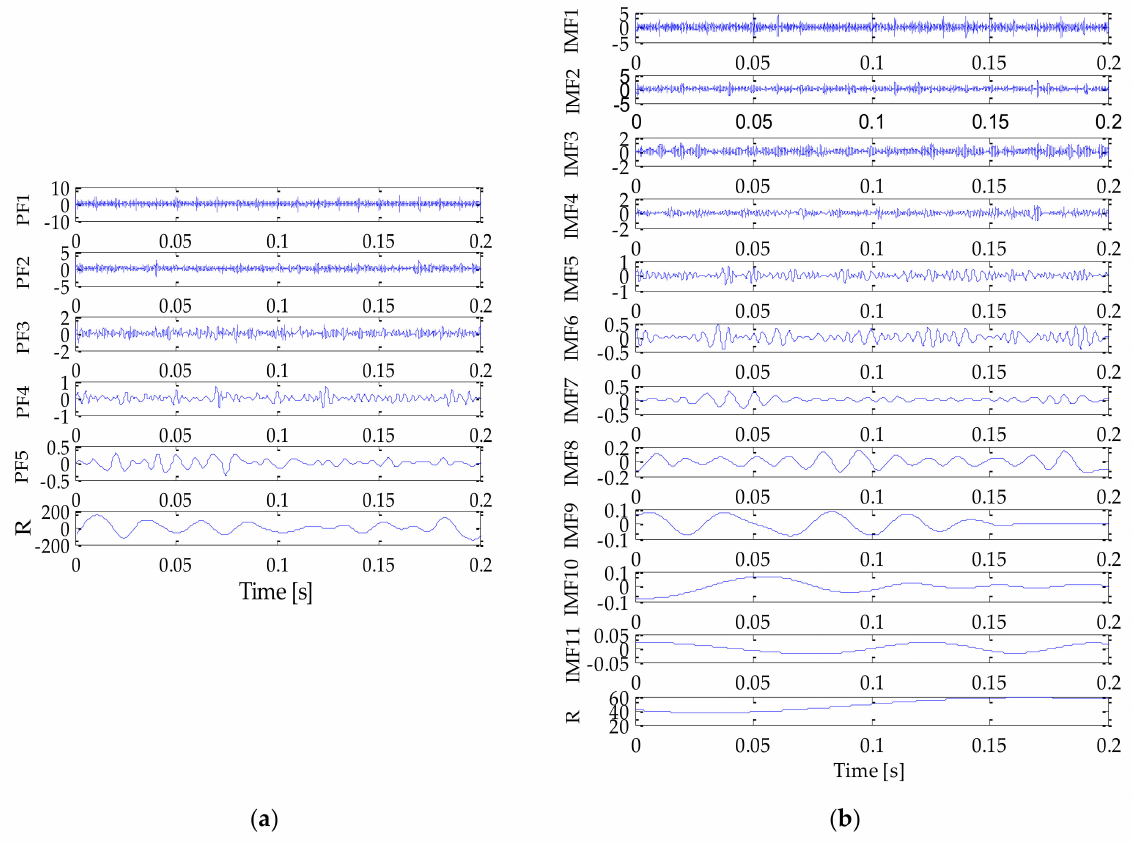
Figure 10. LMD ( a ) andEMD ( b ) decomposition